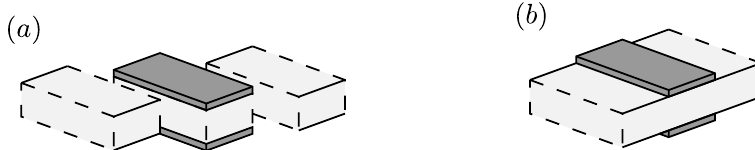
Figure 2. Modelling a unit cell of an electromechanical periodic structure: ( a ) by the finite element method (FEM), ( b ) by the spectral finite element method (SFEM).